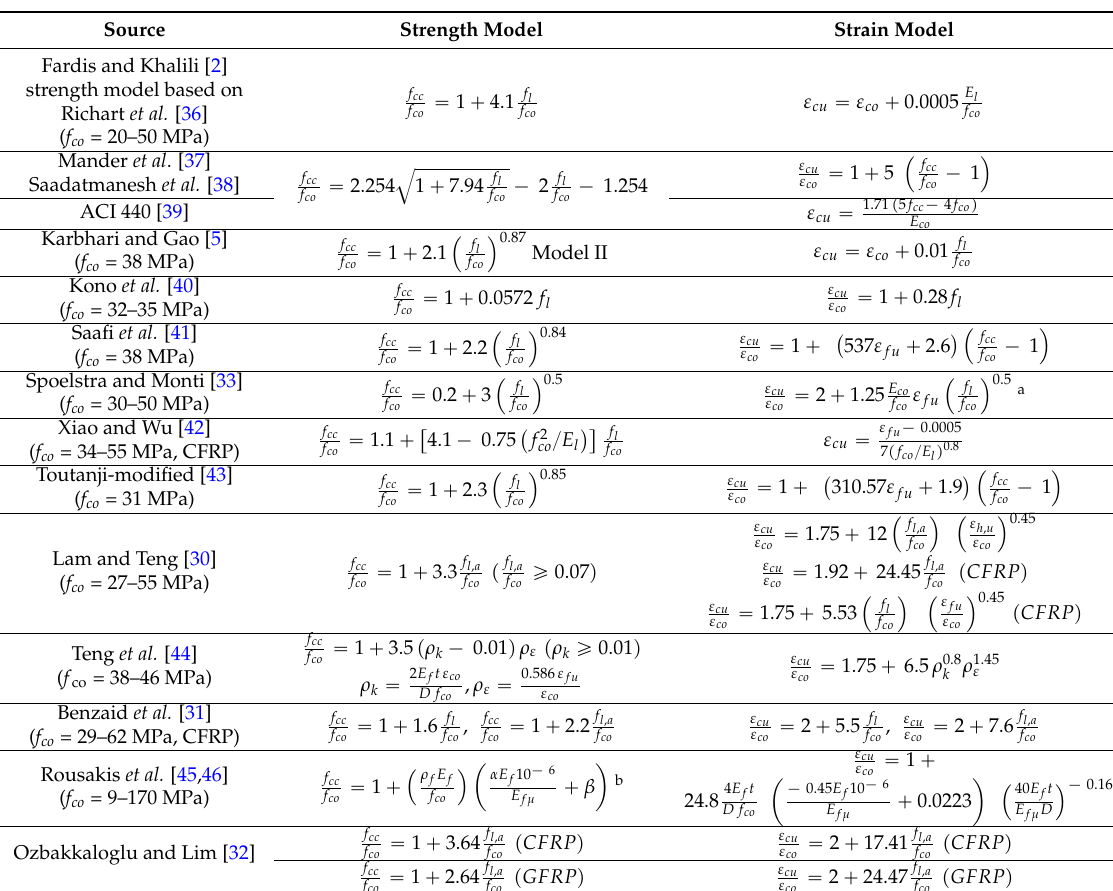
Table 1. Strength and strain models in circular